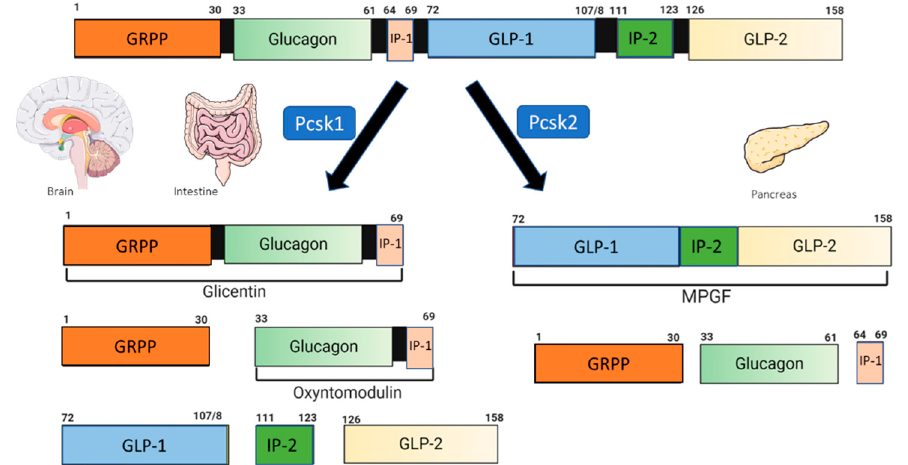
Figure 1. Schematic processing of proglucagon. NTS: nucleus of the solitary tract; GRPP: glicentin- related polypeptide; IP-1: intervening peptide-1; IP-2: intervening peptide-2; GLP-1: glucagon-like peptide-1; GLP-2: glucagon-like peptide-2; MPGF: major proglucagon fragment; PCSK1: prohormone convertase 1/3; PCSK2: prohormone convertase 2. Modified from [36]. Created with Bioren- der.com.